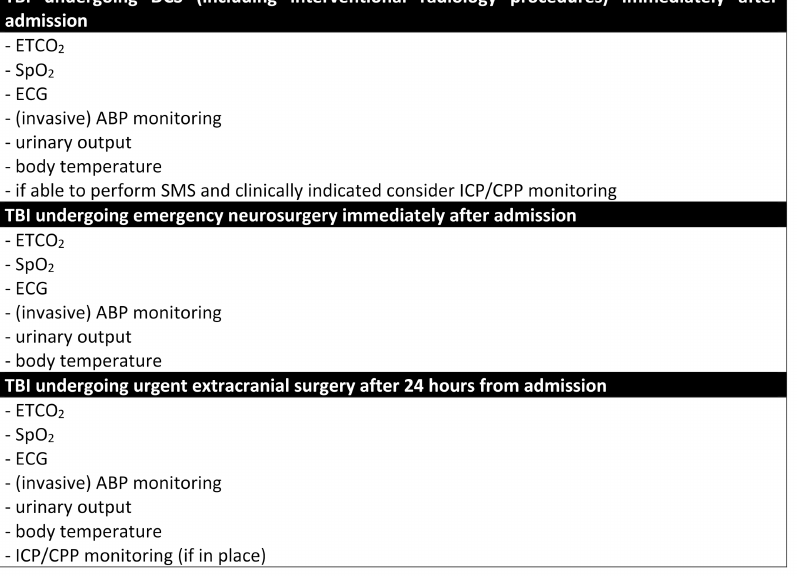
Figure 3. Suggested monitoring for severe TBI patients with polytrauma undergoing surgery. TBI, traumatic brain injury; DCS, damage control surgery; ETCO 2 , end-tidal carbon dioxide; SpO 2 , peripheral oxygen saturation; ECG, electrocardiogram; ABP, arterial blood pressure; ICP, intracranial pressure; CPP, cerebral perfusion pressure; SMS simultaneous multisystem